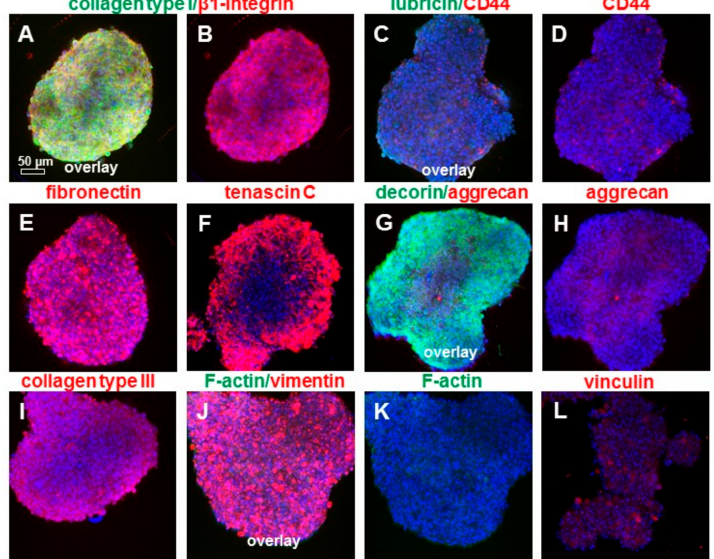
Figure 10. The immunolabeling of ECM and cytoplasmatic markers in ITB spheroids. Mini-spheroids consisting of 25.000 ITB cells after 3 days of spheroid formation were immunolabeled for collagen type I (green) and β 1-integrin (red) ( A , B ), lubricin (green) and CD44 (red) ( C , D ), fibronectin ( E ) (red), tenascin C ( F ) (red), decorin (green) and aggrecan (red) ( G , H ), collagen type III ( I ) (red), and vimentin (red) as well as stained with phalloidin-488 to visualize F-actin fibers (green) ( J , K ); and immunolabeled for vinculin ( L ) (red). The cell nuclei were counterstained using DAPI (blue). Scale bar: 50 µ